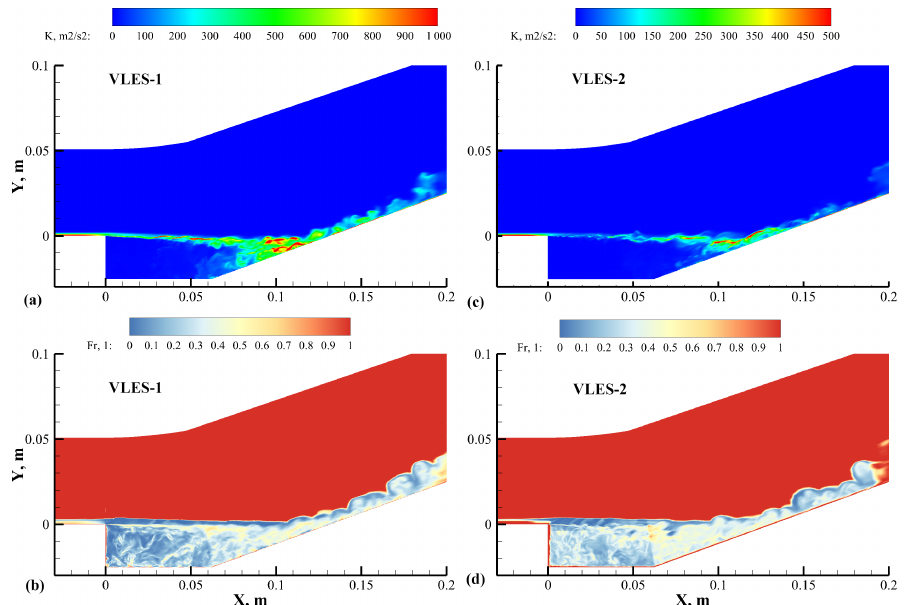
Figure 9. Contours of turbulent kinetic energy and resolution control function from the VLES results: ( a , b ) VLES-1, ( c , d ) VLES-2.